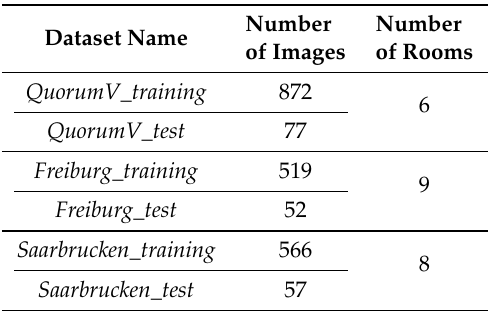
Figure 5. Bird’s eye view of the COsy Localization Database (COLD). ( a ) Freiburg and ( b ) Saarbrücken environment. Extracted from https://www.nada.kth.se/cas/COLD/. Table 1. Datasets used to carry out the